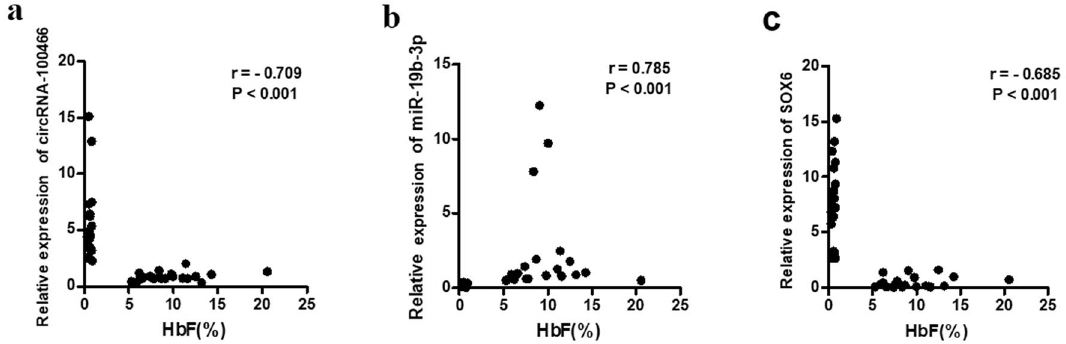
Figure 5. Associations between hsa-circRNA-100466/miR-19b-3p/ SOX6 and HbF levels. The Spearman correlation coefficient was utilized to evaluate associations between ( a ) hsa-circRNA-100466 and HbF, ( b ) miR- 19b-3p and HbF, and ( c ) SOX6 and